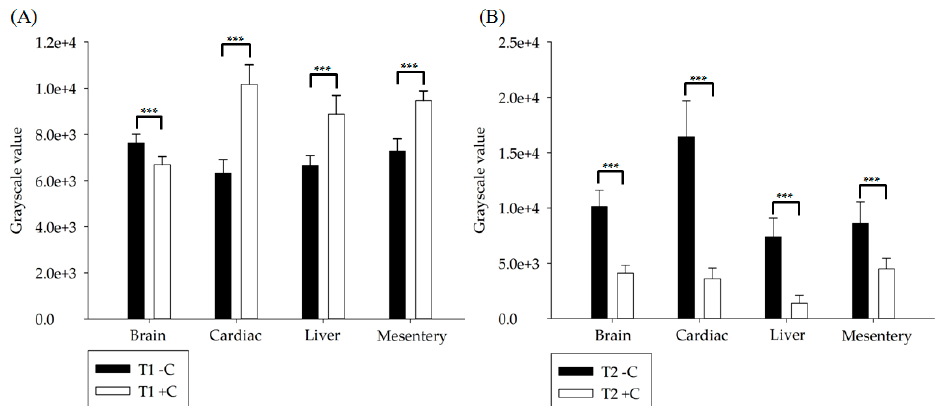
Figure 5. ( A ) T1W pulse sequence imaging. ( B ) T2W pulse sequence imaging. The visualized grayscale numerical statistics of the brain, heart, liver and mesentery before and after injection of diluted paramagnetic contrast agent Gd-DTPA-BMEA and superparamagnetic contrast agent iron oxide were analyzed and compared, and one-way ANOVA grayscale statistical analysis was conducted. All p values less than 0.001 are summarized with three asterisks.